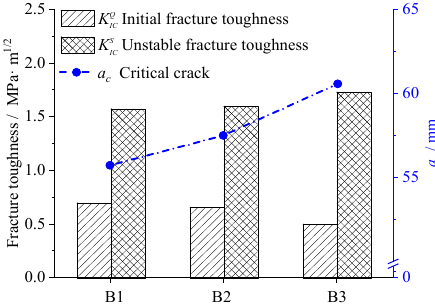
Figure 12. Fracture toughness and critical crack length.